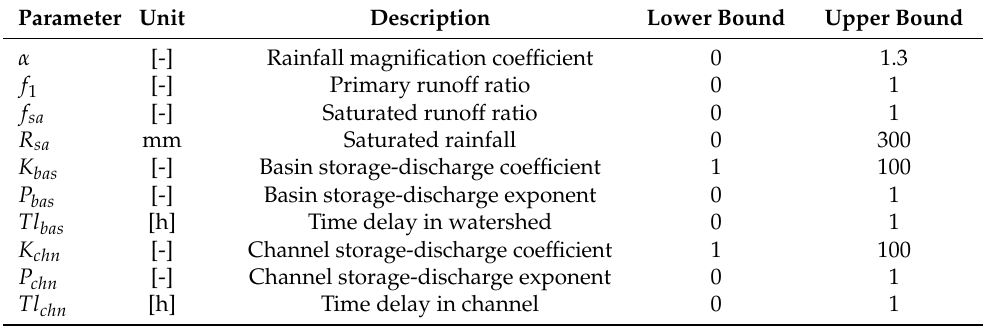
Table 2. Description of the SFM